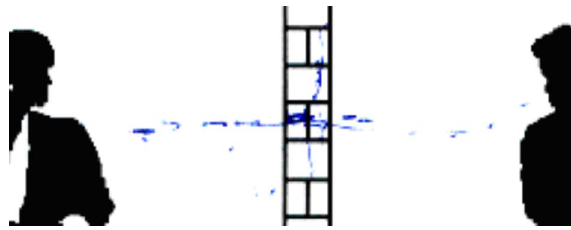
FIG. 12. (cid:1) Color (cid:2) Student’s drawing over provided template to illustrate the statement (cid:1) Hope